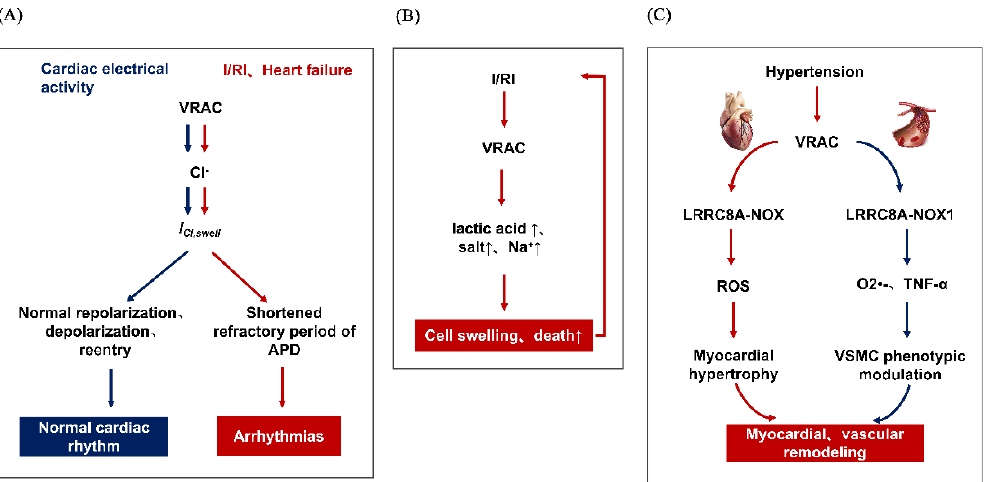
Figure 1. The role of VRAC in several cardiovascular diseases, ( A ) VRAC and arrhythmias, the blue part represents normal electrical activity of the heart, ( B ) VRAC and myocardial ischemic disease, ( C ) VRAC and cardiovascular remodeling, including the myocardial remodeling(red part) and vascular remodeling(blue part).